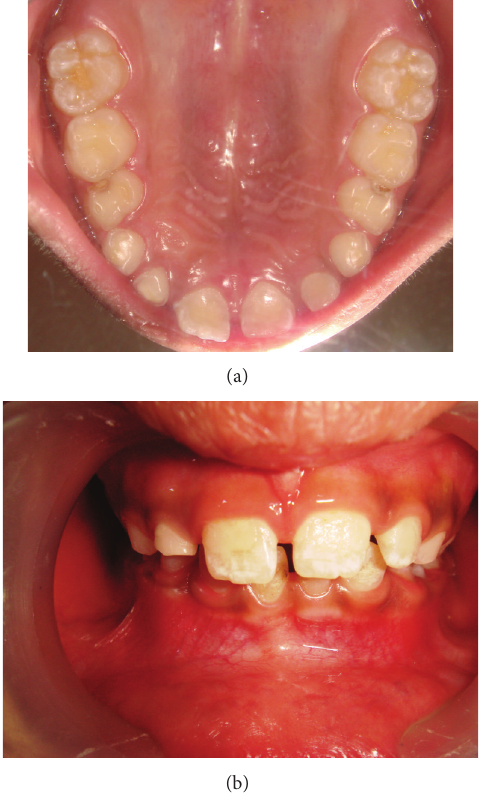
Figure 2: Proclination of teeth and increased overjet and overbite with high palatal vault.